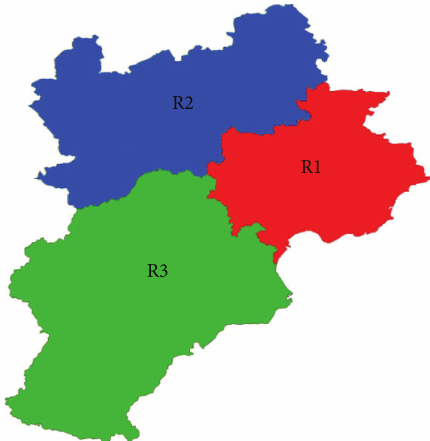
Figure 9: Drought-based regionalization in Beijing-Tianjin-Hebei metropolitan